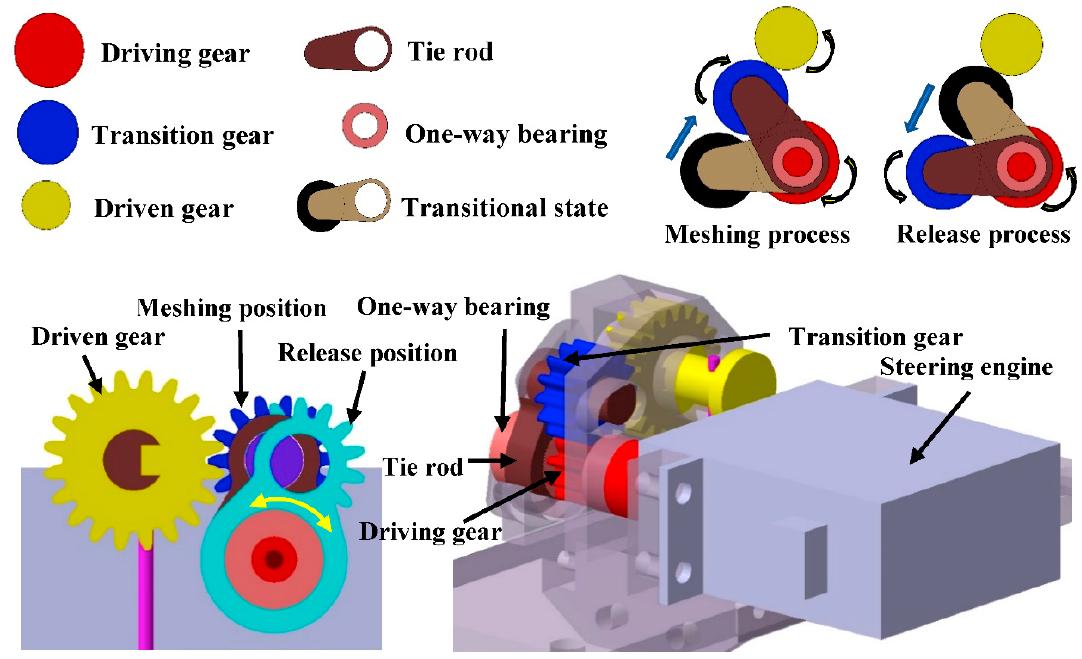
Figure 4. Schematic diagram of the clutch structure.